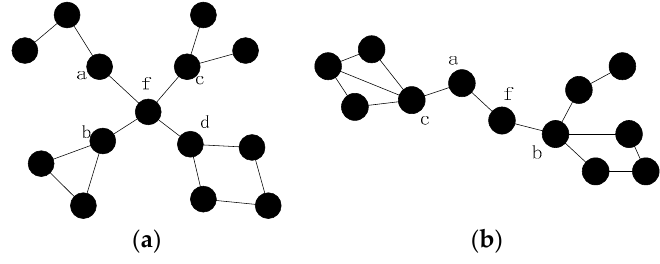
Figure 2. ( a ) Multiple disconnected blocks; and ( b ) linear node failure.